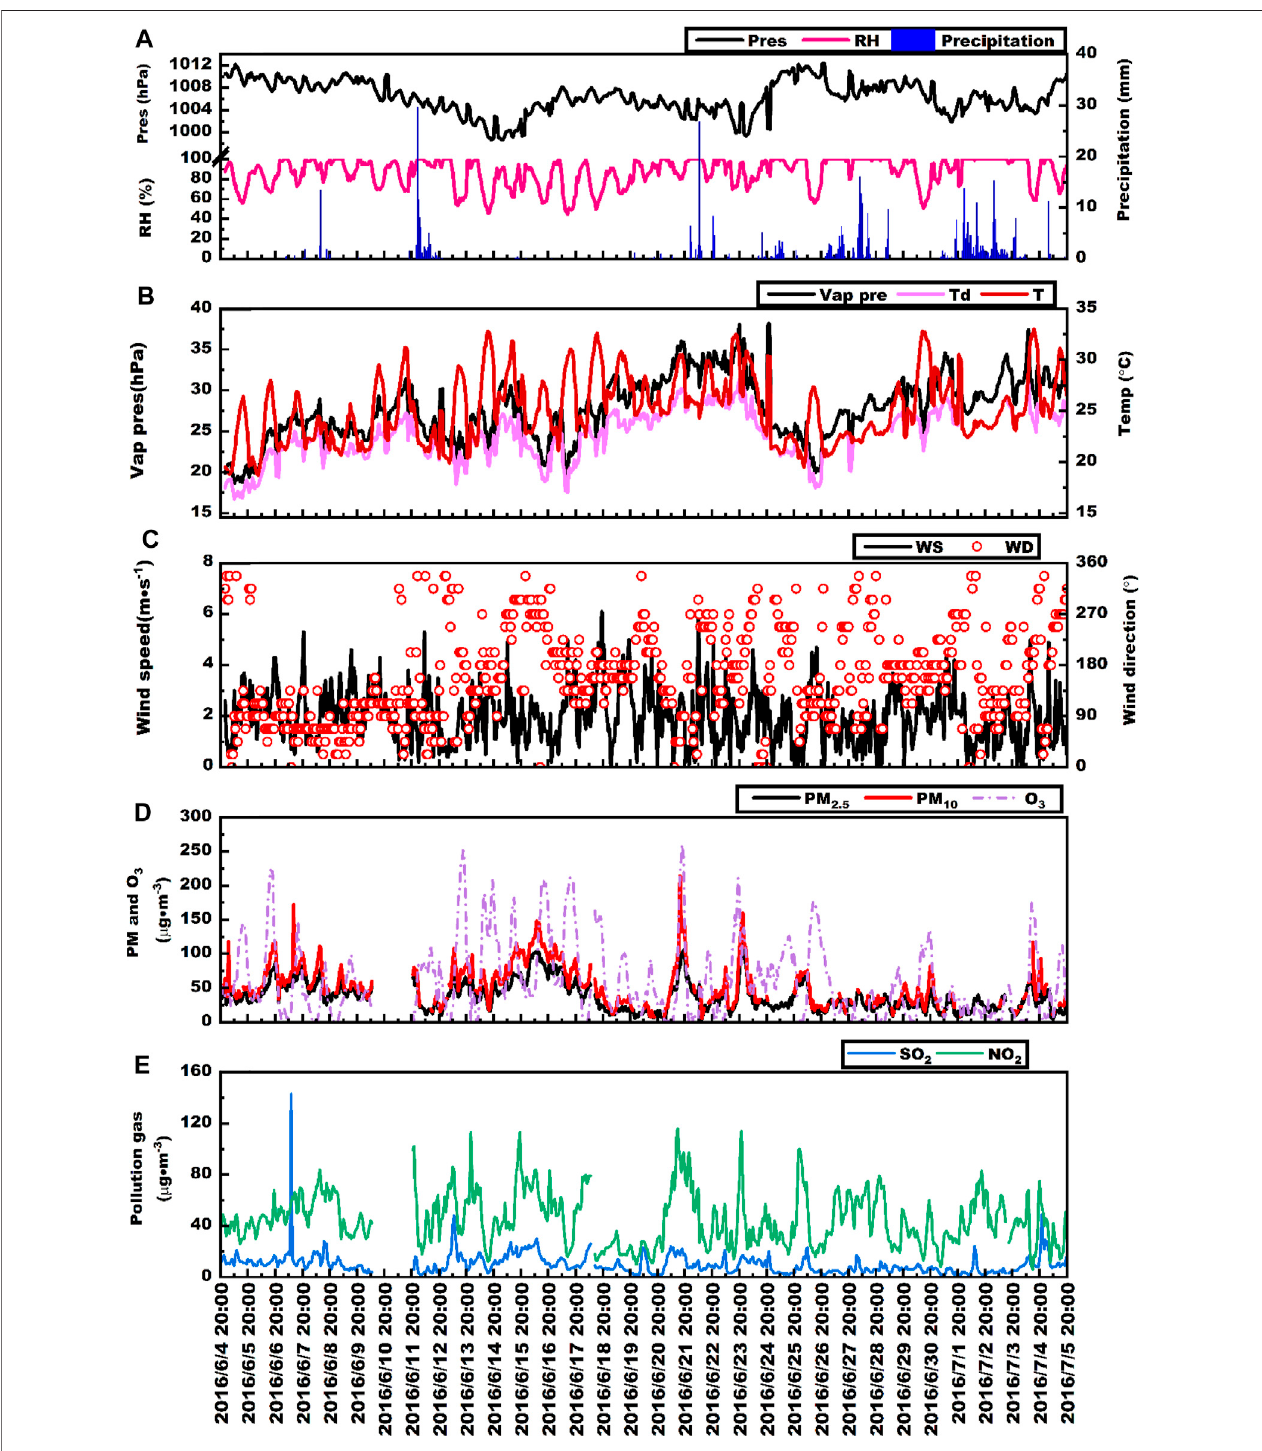
FIGURE 2 | Changes of meteorology, gaseous pollutants records, PM 2.5 and PM 10 concentrations in sampling periods.